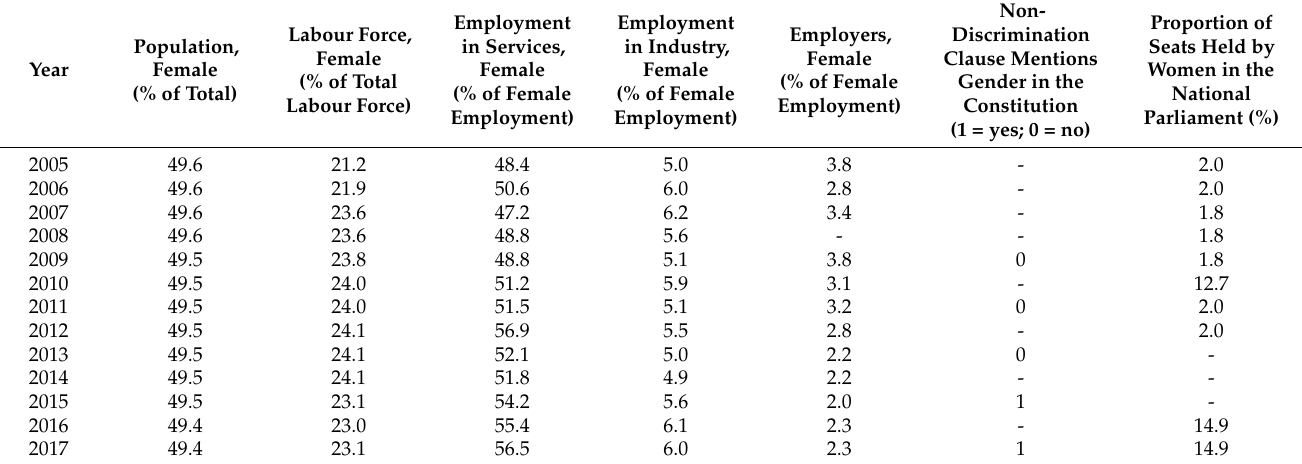
Table 1. Female presence in various